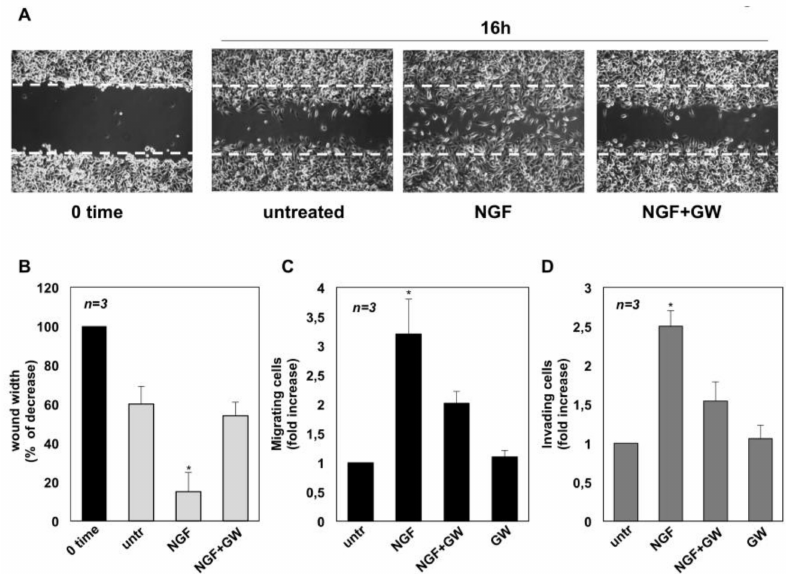
Figure 4. Nerve growth factor (NGF) triggers migration and invasiveness in PC3 cells. In A , quiescent PC3 cells were wounded and then left untreated or treated with NGF for the indicated times. GW441756 (GW) was added at 1 µ M. Phase-contrast images are representative of three di ff erent experiments, each in duplicate. In ( B ), the wound area was measured as in Figure 2B and data are presented as % in wound width over the control cells analyzed at time 0. Means and SEMs are shown. n represents the number of experiments. Quiescent C4-2B cells were used for migration ( C ) and invasion ( D ) assays in Boyden’s chambers pre-coated with collagen or Matrigel, respectively. The indicated compounds were added to the upper and the lower chambers. NGF was used at 100 ng / mL and GW441756 (GW) was used at 1 µ M. After 7 h ( C ) or 24 h ( D ), migrating or invading cells were counted as reported in Methods. Results from three di ff erent experiments were collected and expressed as fold increase. Means and standard error of the means (SEMs) are shown. n represents the number of experiments. * p < 0.05 for the indicated experimental points vs. the corresponding untreated